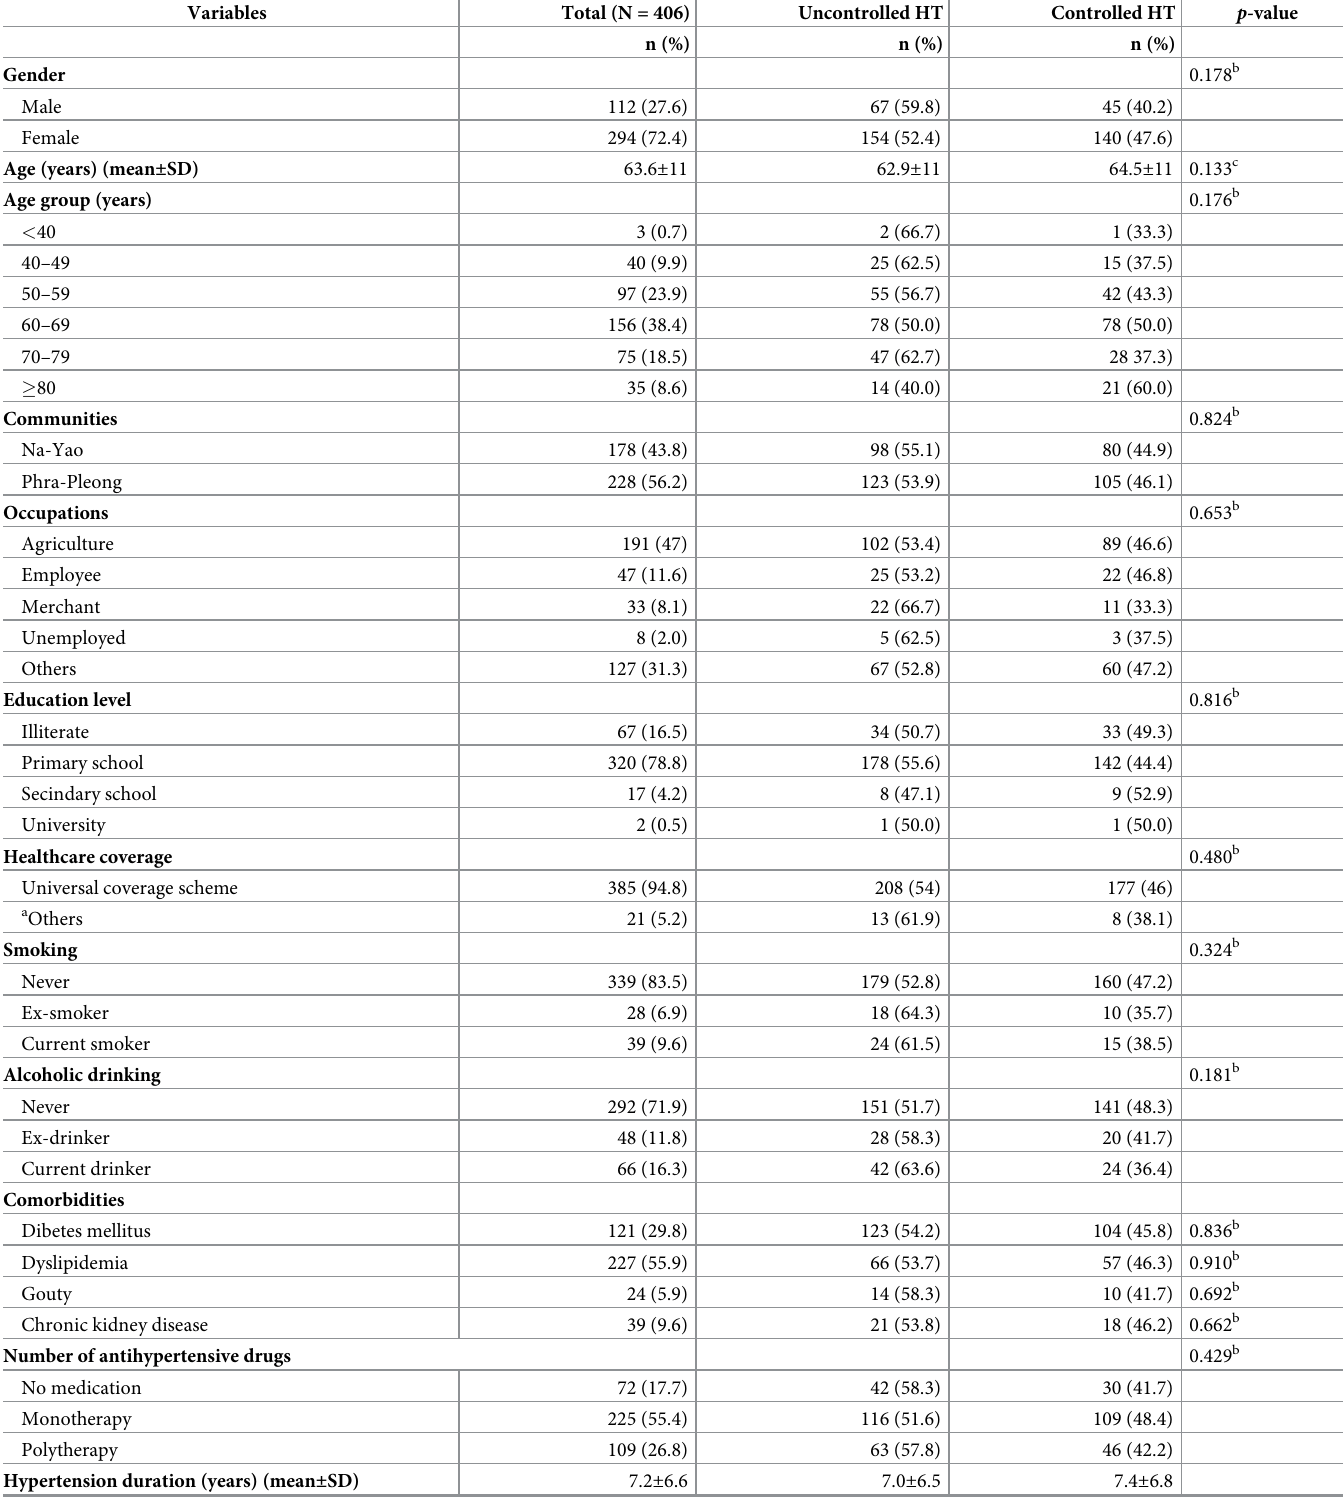
Table 1. Characteristics of adults with hypertension in the rural community, central